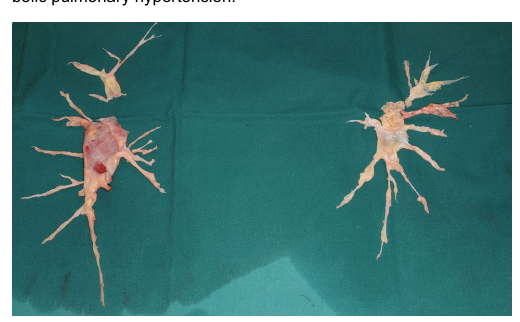
Figure 2: Resected tissue from patient with chronic thromboem- bolic pulmonary